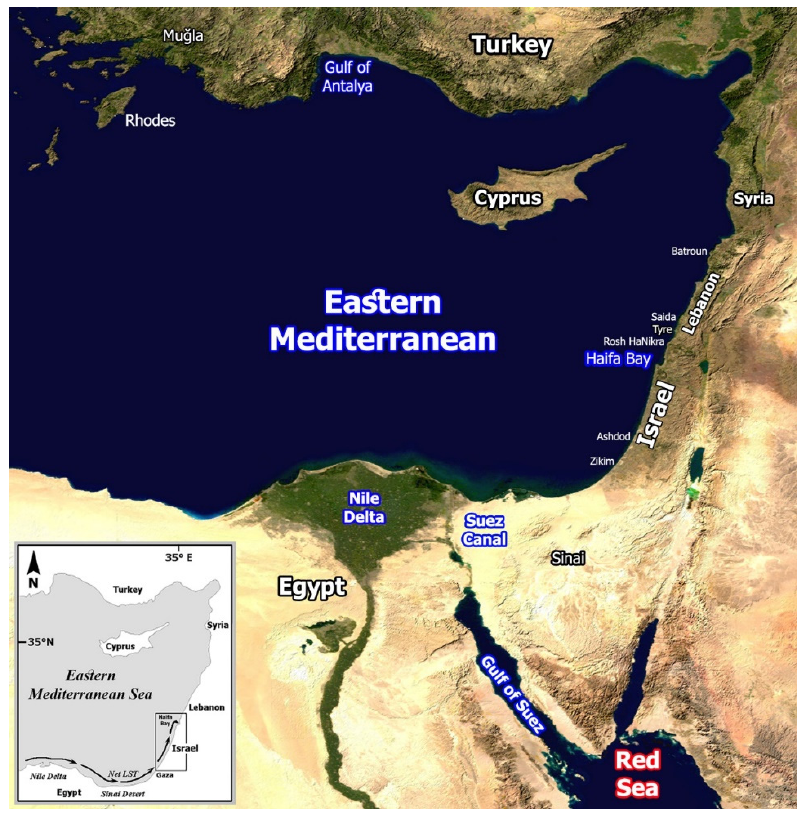
Figure 1. Eastern Mediterranean. The Nile littoral cell net longshore sand transport (LST) direction (black arrows) (bottom inset). Background: part of “Blue Marble: Land Surface, Shallow Water, and Shaded Topography”. NASA Goddard Space Flight Center Image by Reto Stöckli, Robert Simmon and MODIS Groups; https://visibleearth.nasa.gov/images/57752/blue-marble-land-surface-shallow- water-and-shaded-topography (accessed on 11 February 2002).